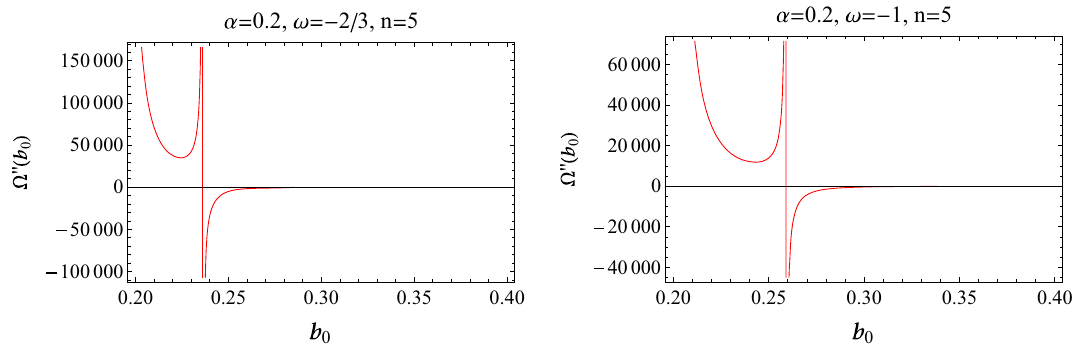
dinary quintessence parameter for both barotropic and gen- eralized Chaplygin gas